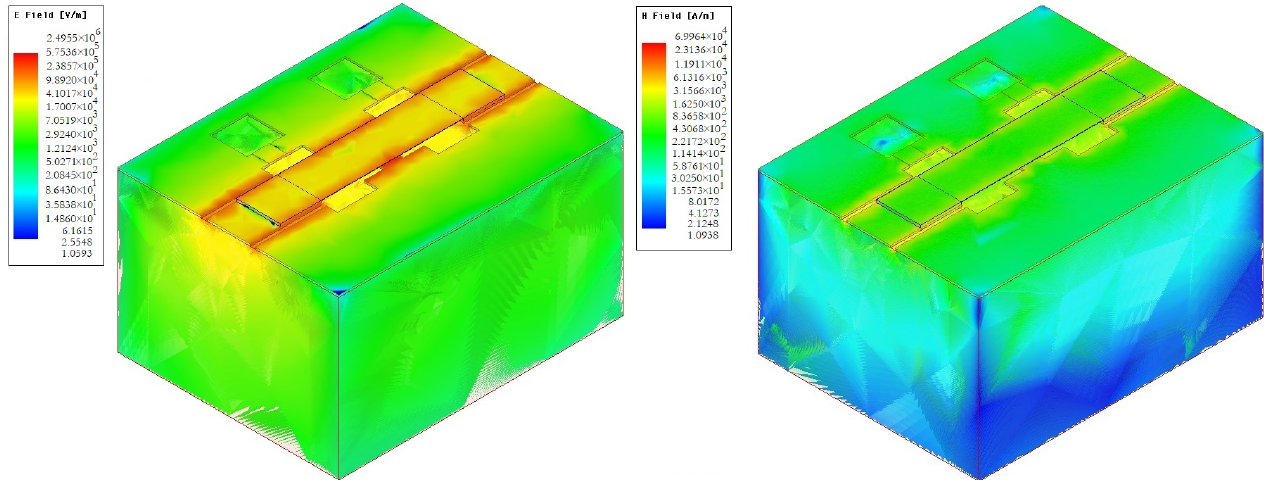
Figure 9. The distribution of E and H fields in the developed design of CPW